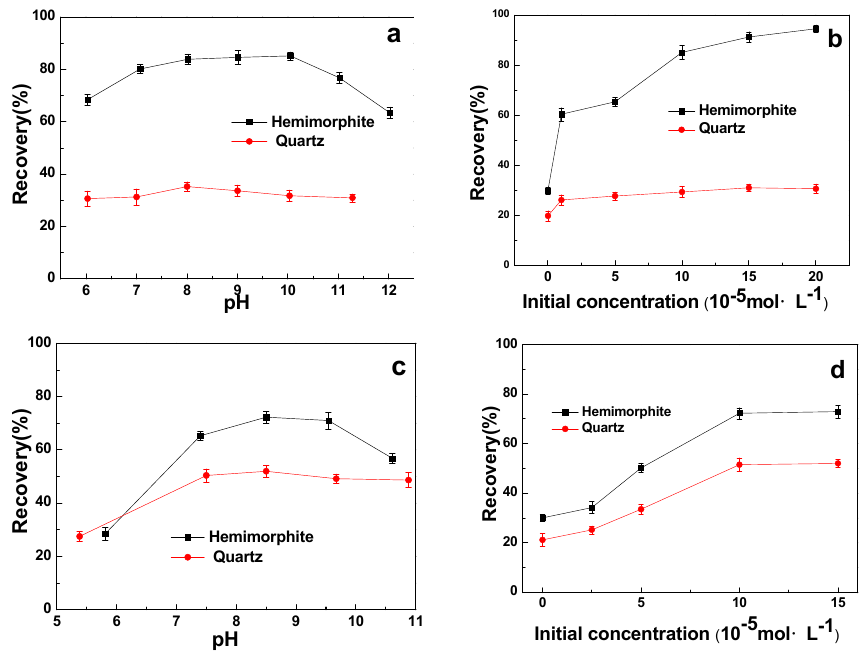
Figure 2. Flotation recovery of hemimorphite and quartz as a function of pH (under 1 × 10 − 4 mol · L − 1 HDDPA ( a ) or lauric acid ( c )) and initial concentration of HDDPA ( b ) or lauric acid ( d ) (under pH 8.5).